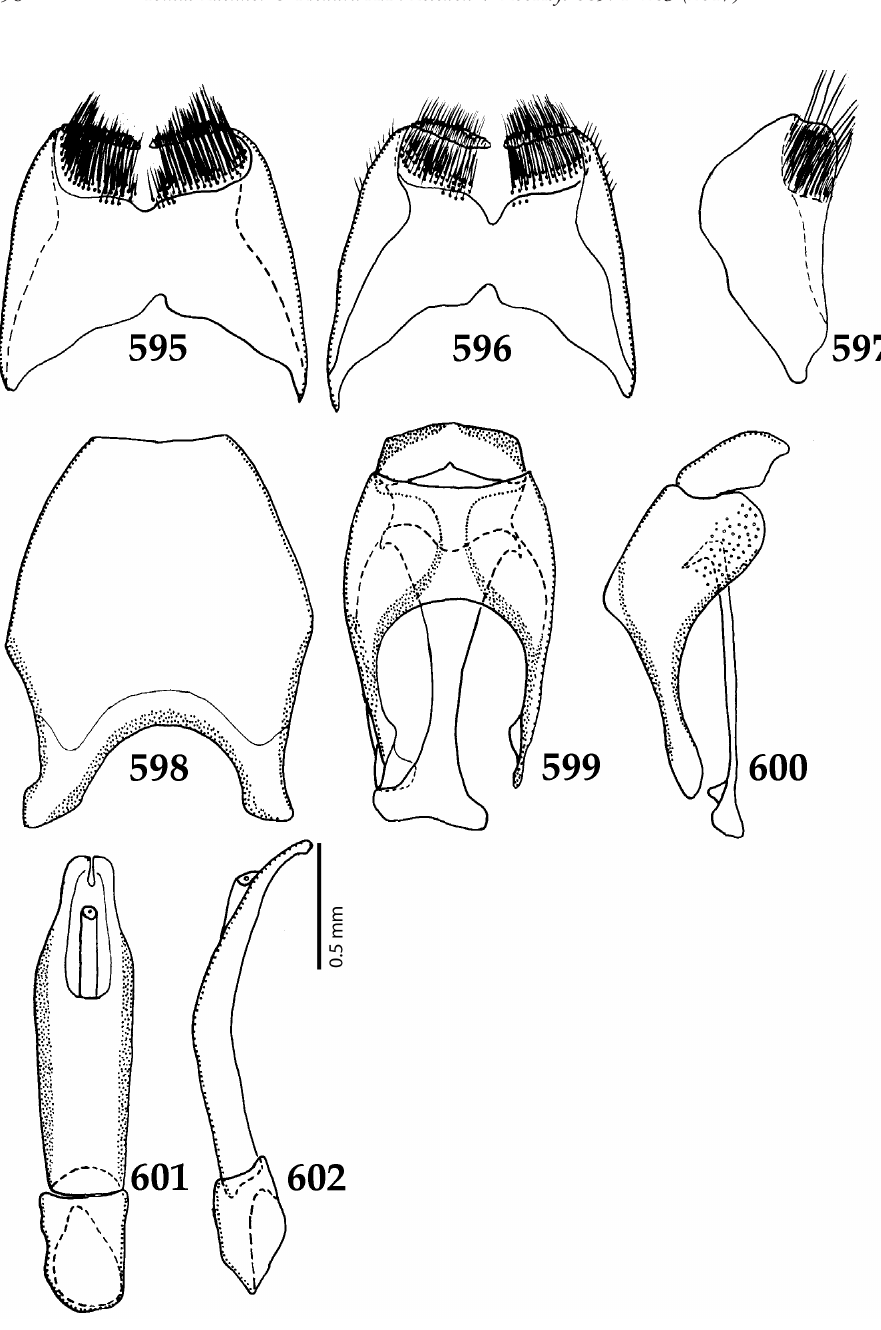
view 596 ditto, dorsal view 597 ditto, lateral view 598 male terminalia: 8 th tergite, dorsal view 599 male terminalia: 9 th + 10 th tergites, dorsal view; spiculum gastrale, ventral view 600 male terminalia: 9 th + 10 th tergites; spiculum gastrale, lateral view 601 male terminalia: aedeagus, dorsal view 602 ditto, lateral